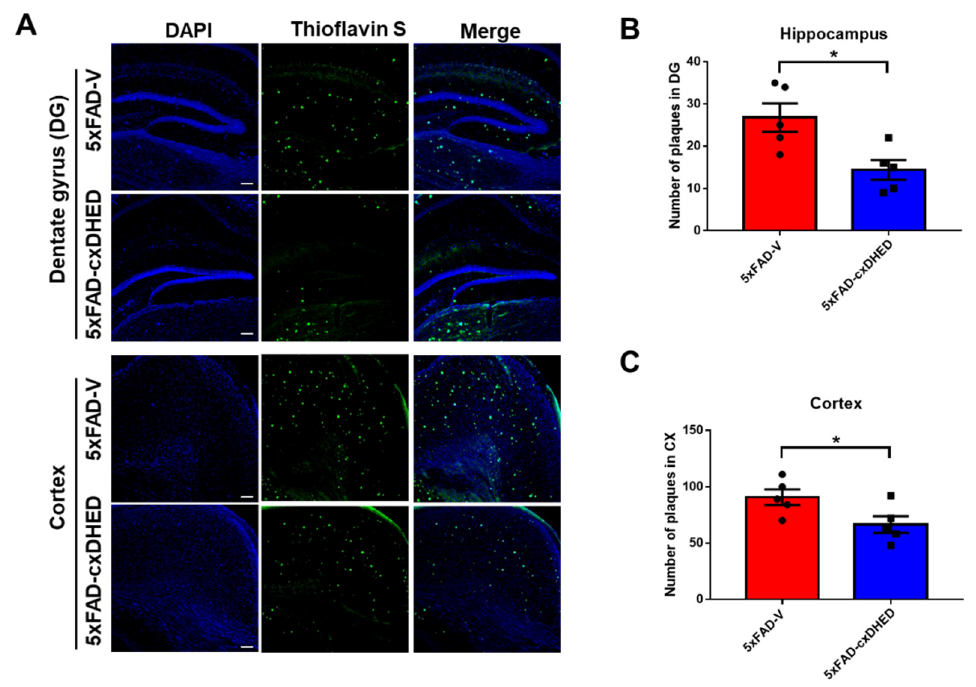
Figure 2. cx-DHED suppressed the formation of amyloid plaques. ( A ) Images showing the thioflavin-S stain localized to the amyloid plaques in the hippocampus (dentate gyrus) and cortex of 5xFAD mice. Quantification was determined as the number of plaques in the hippocampus ( B ) and cortex ( C ). Values are expressed as the mean ± standard error of the mean (5xFAD; n = 5, 5xFAD-cx-DHED; n = 5). Scale bars, 100 μ m. * p < 0.05. Statistical analysis between the two groups was performed using the Student t -test.